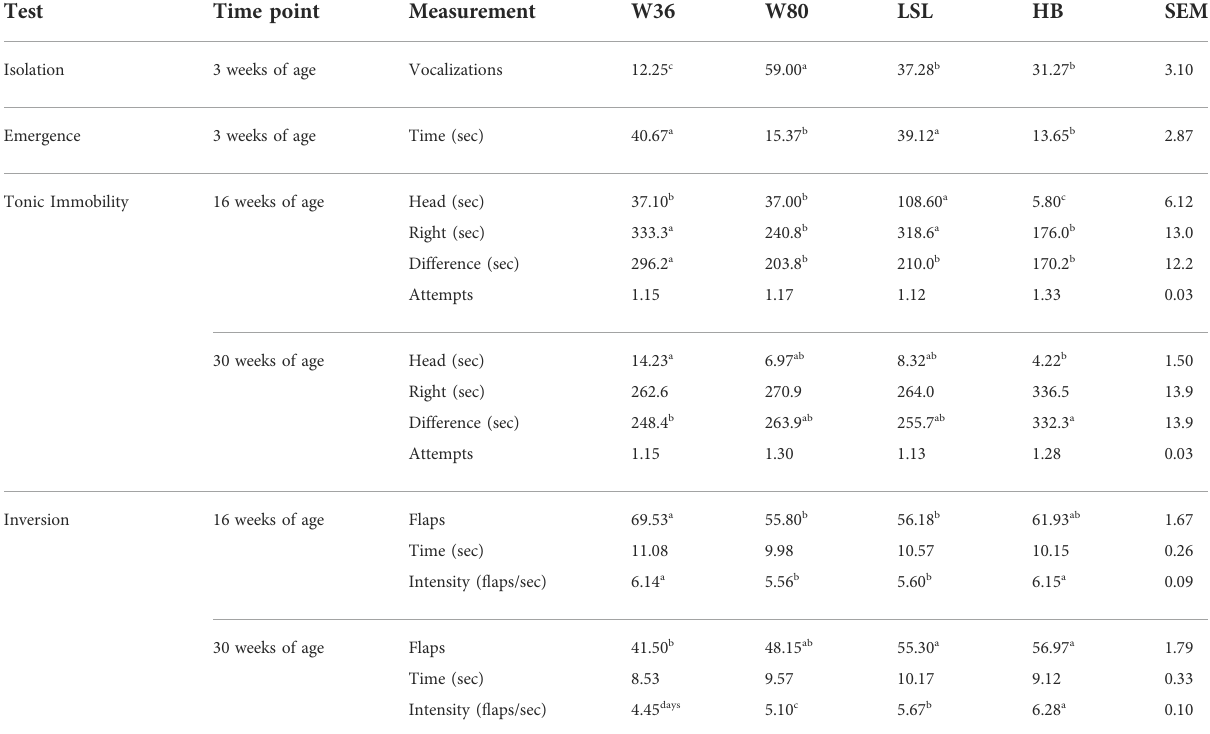
TABLE 1 Fear response of four strains of commercial layers (W36, W80, LSL, and Hy-Line Brown (HB)) at 3, 16, and 30 weeks of